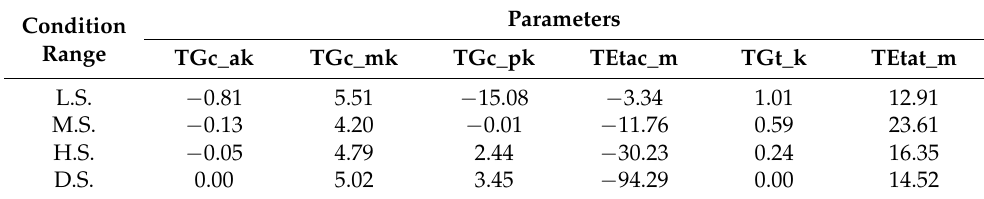
Table 4. All potential tuning factors.